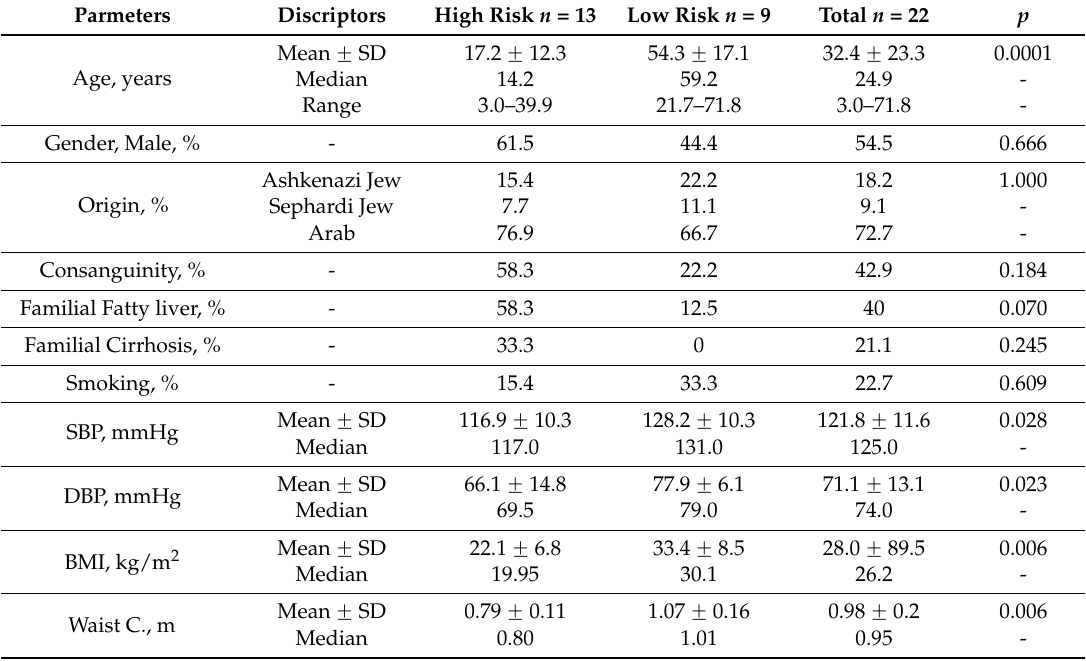
Table 1. Baseline characteristics of participants.